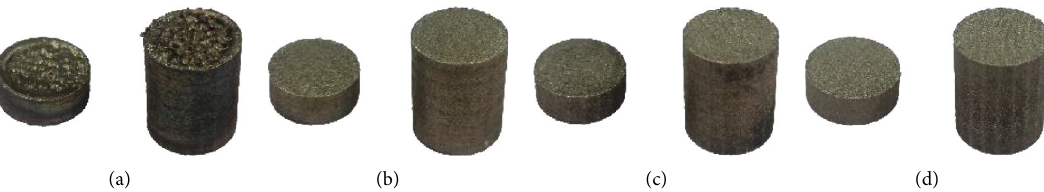
Figure 3: Physical drawings of SLM 316L stainless steel with different process parameters. (a) 350mm/s, (b) 650mm/s, (c) 950mm/s, and (d) 1250mm/s.